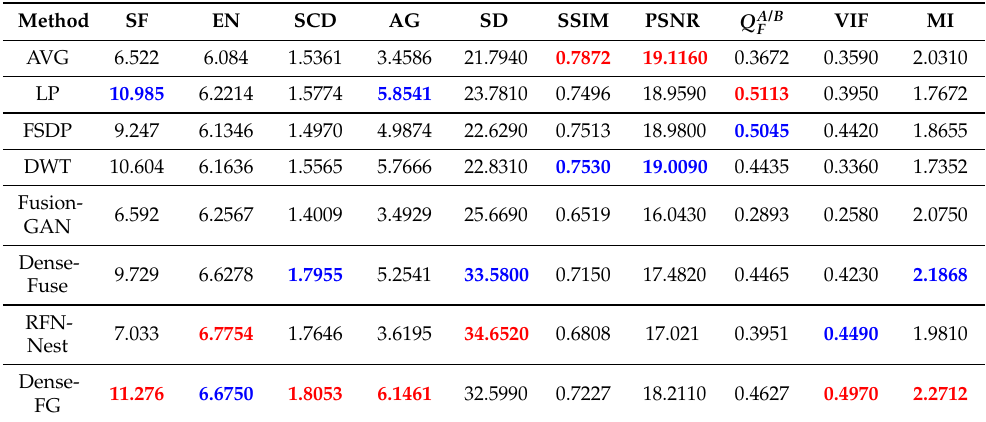
Table 3. Mean values of image metrics for different fusion algorithms